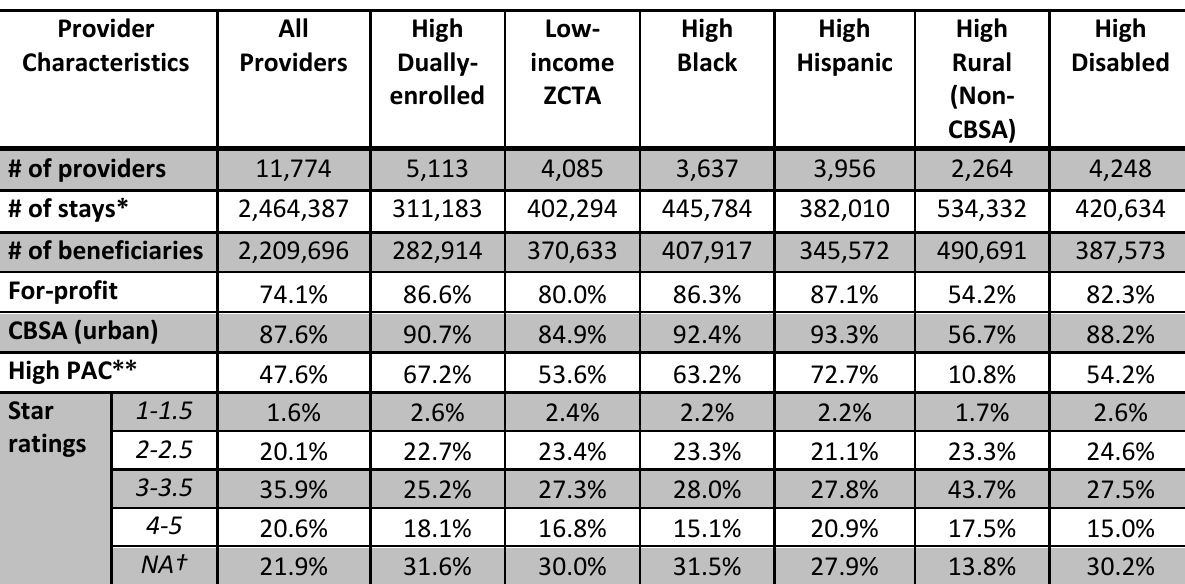
Table 13.2: HHA Characteristics, FYs